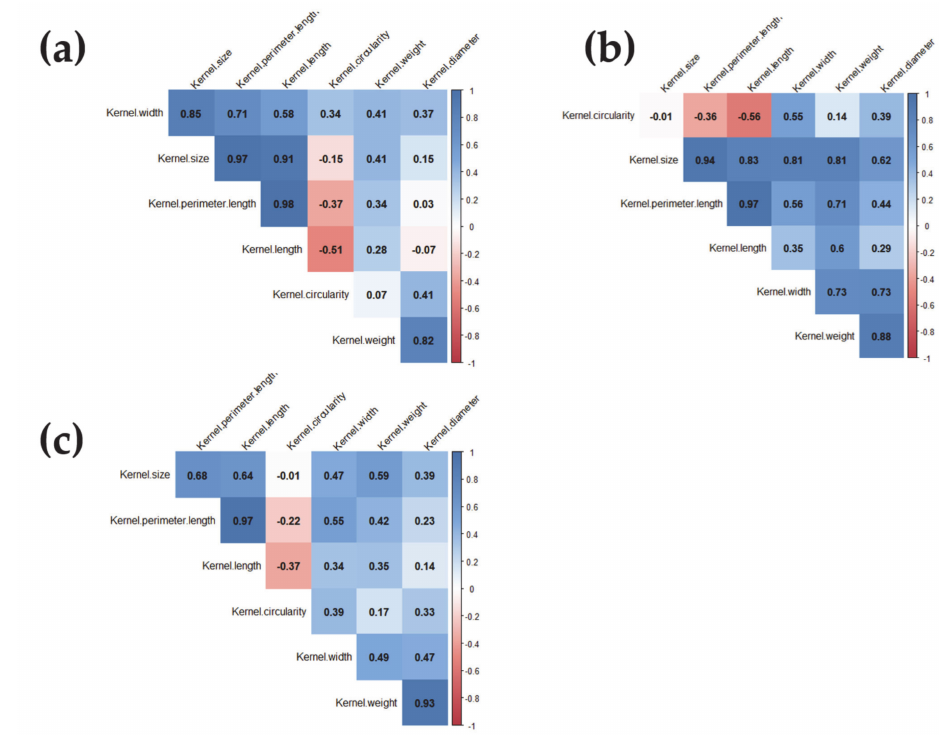
Figure 2. Correlation coefficient for kernel weight and shape-related traits under ( a ) optimum; ( b ) heat; and ( c ) combined heat–drought conditions. Absolute values >0.15 were significant at p = 0.05; >0.20 were significant at p = 0.01 under optimum, heat and combined heat–drought conditions, whereas absolute values > 26, 29 and 27 were significant at p = 0.001 under optimum, heat and combined heat–drought conditions, respectively.